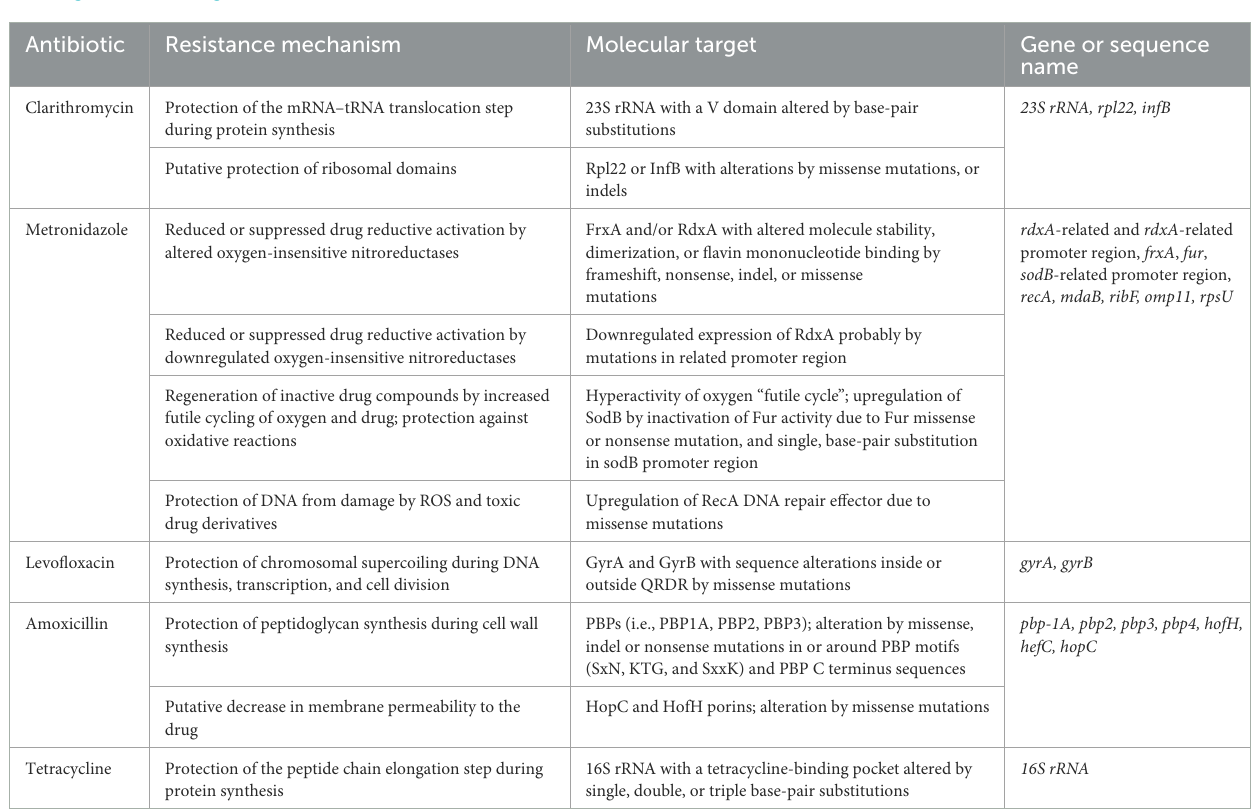
TABLE 1 Biological mechanisms, molecular target, and gene or sequence name of drug resistance in Helicobacter pylori species reported following standard recommendations in molecular diagnostics from the Human Genome Variation Society (Den Dunnen and Antonarakis, 2001; Kusters et al., 2006; Ogino, 2007; Chang et al.,